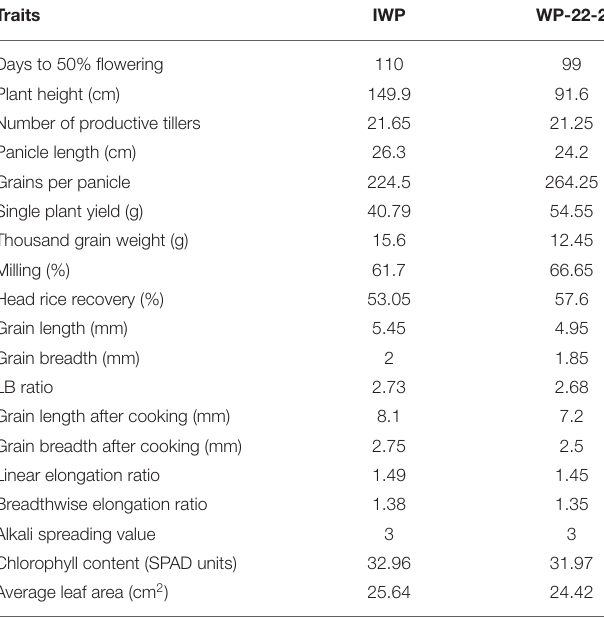
TABLE 1 | Comparison of different traits between Improved White Ponni (IWP) and WP-22-2 in the generation of M 6 .